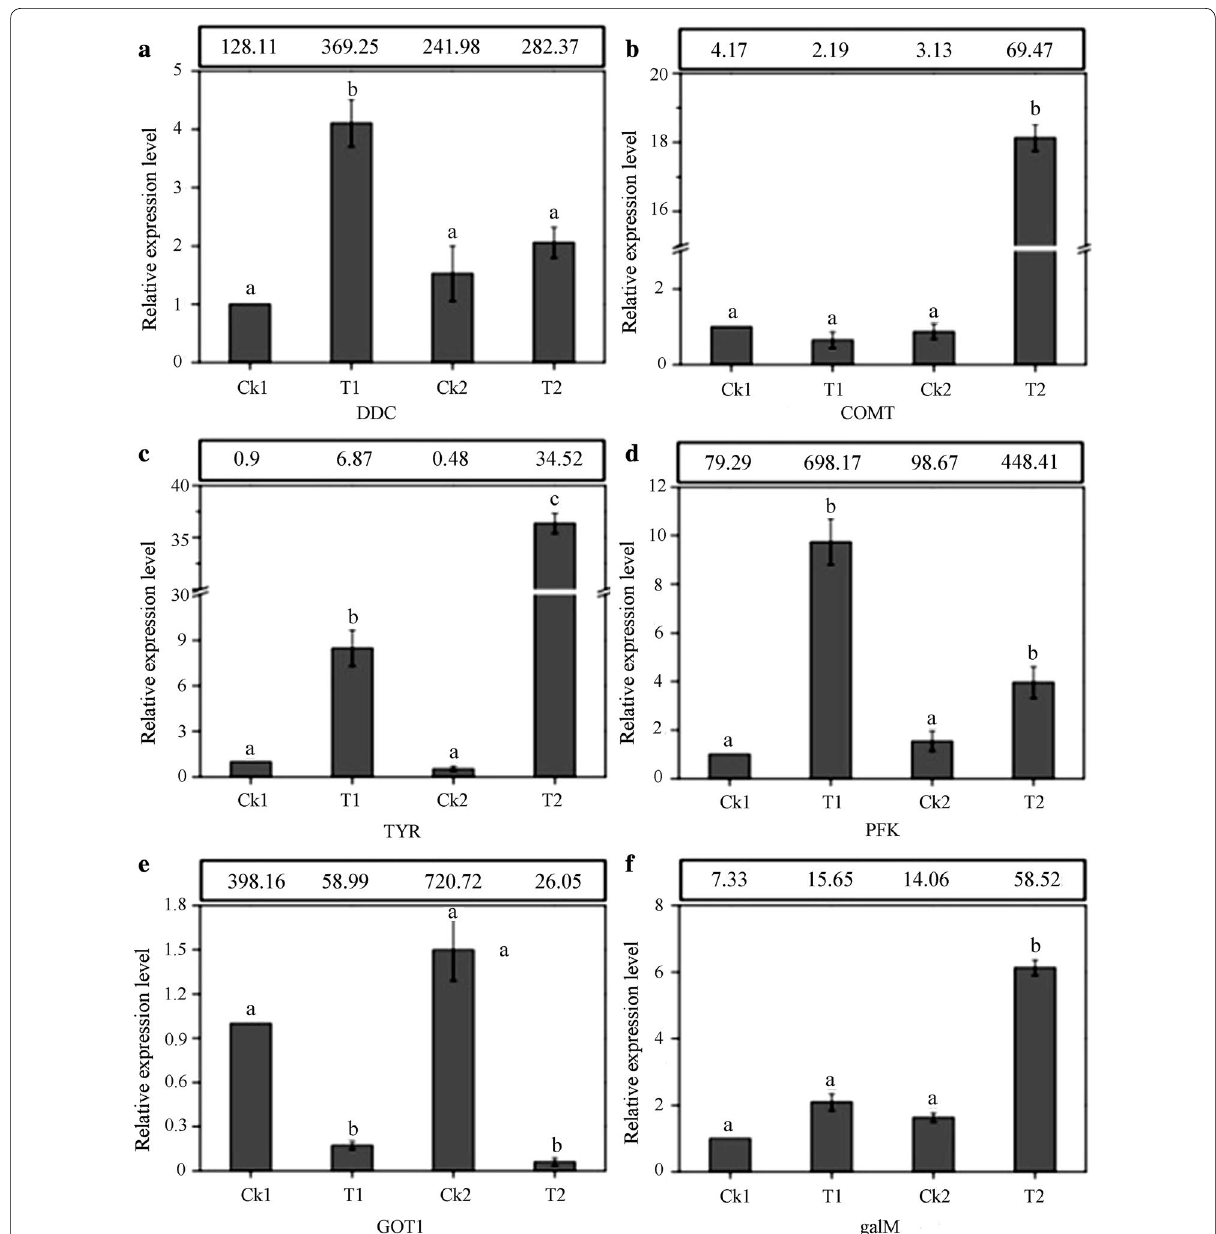
Fig. 7 Validation of DEGs identified in RNA squencing analysis. a DDC; b COMT; c TYR; d PFK; e GOT1 and f galM. The RT-qPCR data represent the mean standard error of three biological replicates. Different lower case letter (a, b, and c) indicates the significant difference among Ck1, T1, Ck2 ± and T2 at P < 0.05. The reads per million reads (RPKM) determined using RNA squencing is shown in the block above each genes. Relative transcript levels are calculated by RT-qPCR with β-tubulin as the